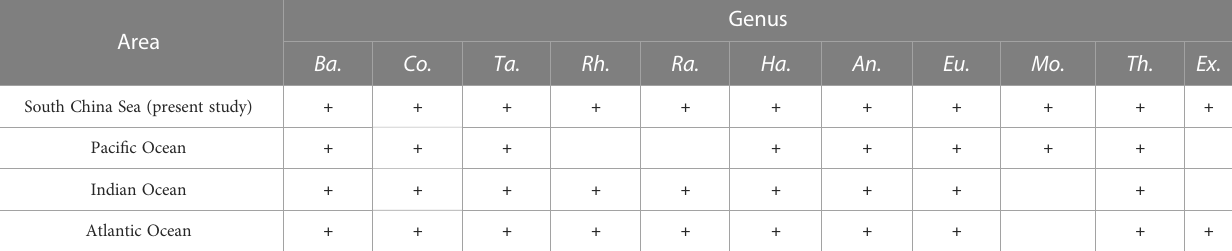
TABLE 7 Comparison of the genus composition of the marine tardigrade fauna of the South China Sea to others.